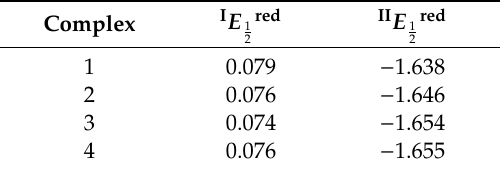
Table 1. Cyclic voltammetric data a for the Fe(III) complexes 1–4.